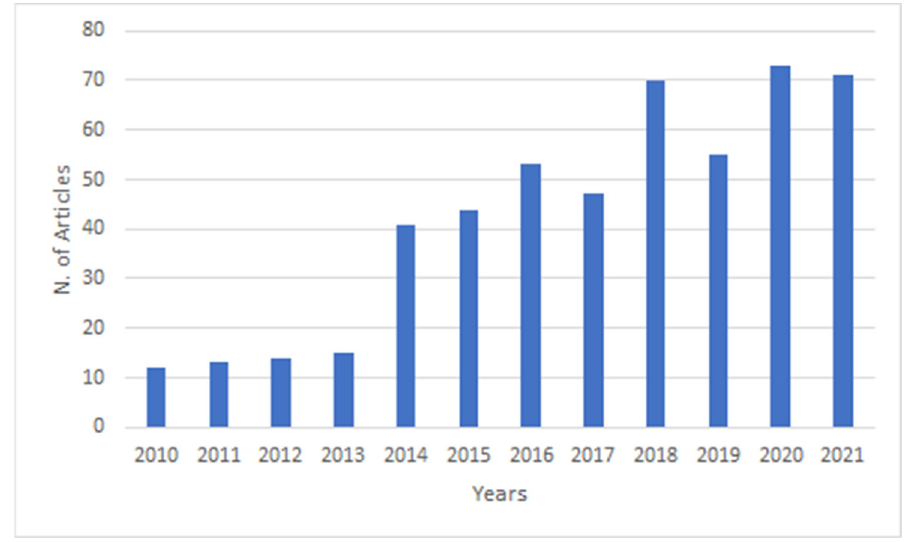
Figure 3. Evolution of the number of articles (2010–2021). Source: Scopus/Biblioshiny.